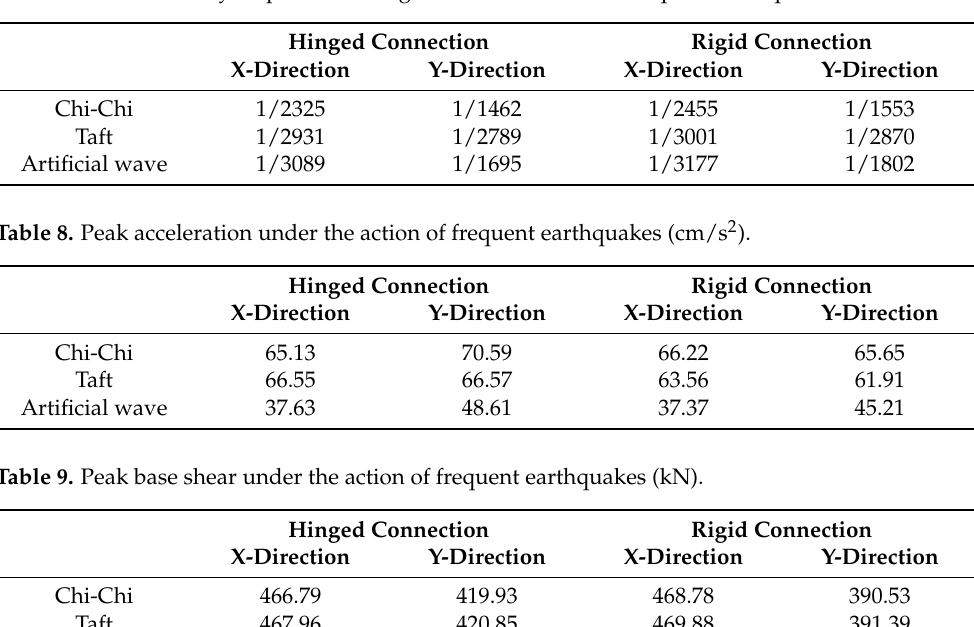
Table 7. Peak interstory displacement angle under the action of frequent earthquakes.